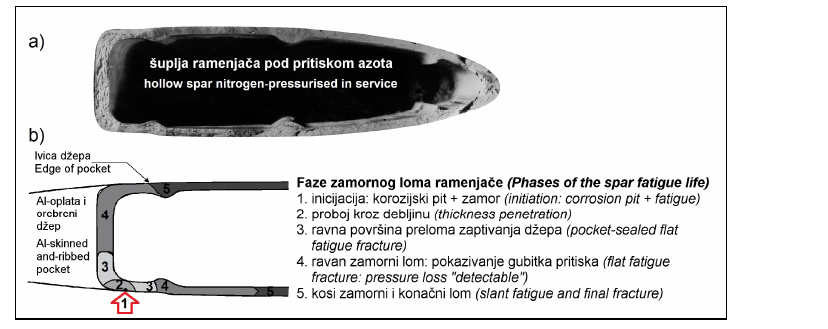
Figure 6 – Recovered blade spar fracture surface and the phases of the fatigue life Рис . 6 – Поврежденная поверхность лонжерена лопасти и фазы усталости Slika 6 – Ošte ć ena površina preloma ramenja č e lopatice i faze zamornog